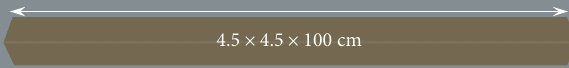
Figure 2: The outcrop sample for long core displacement experiments.